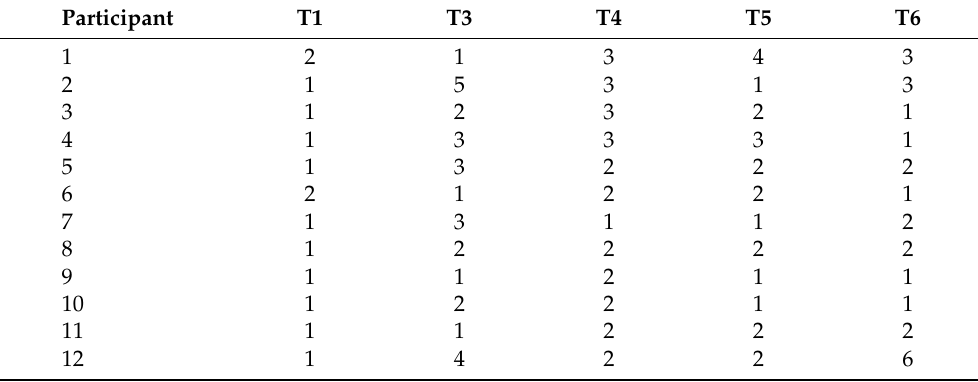
Table 8. Number of requests to check solution during exercise-related